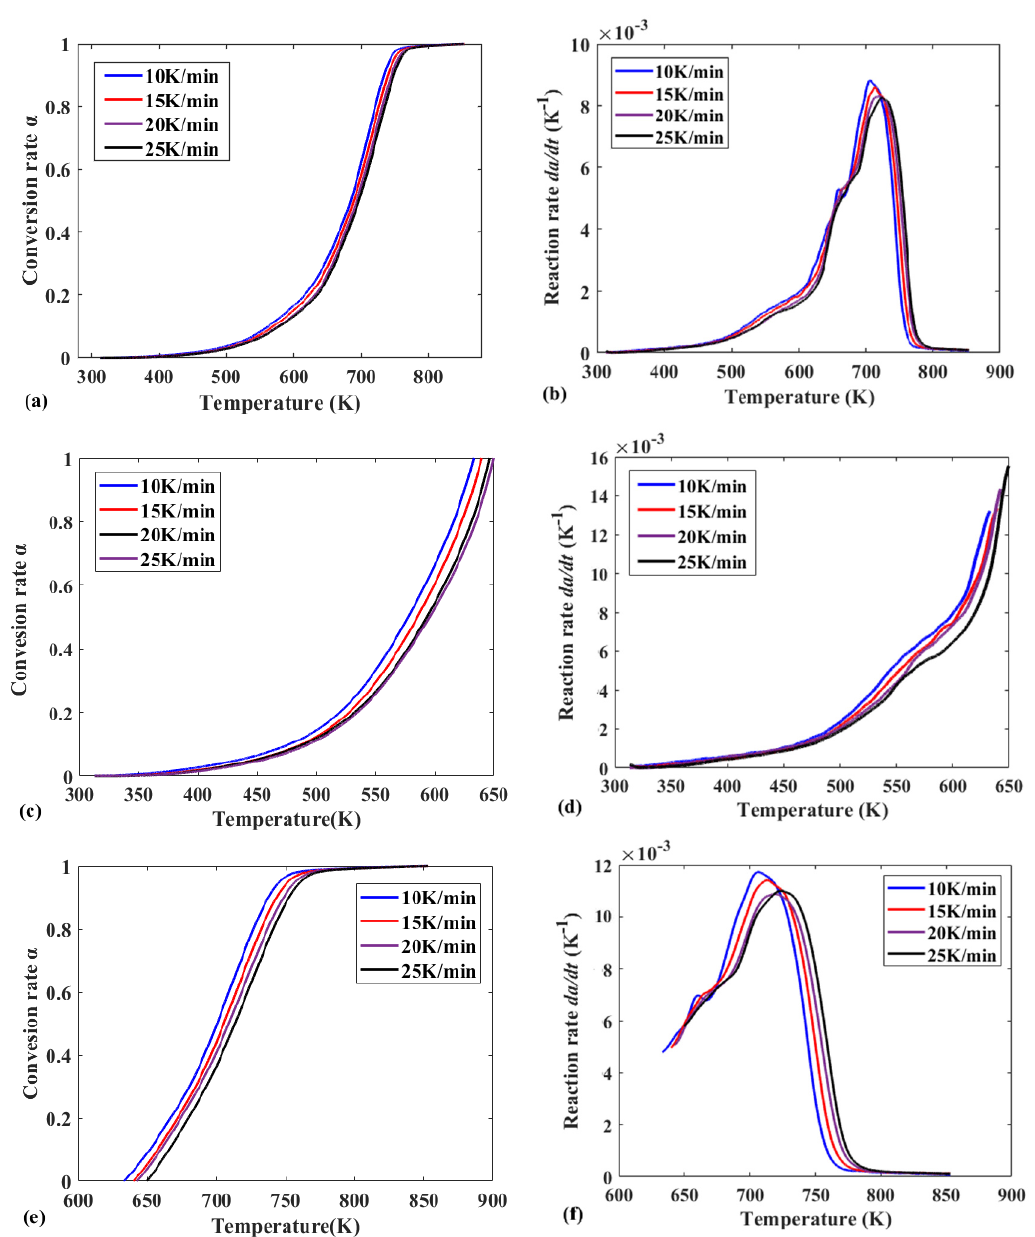
Figure 2. ( a ) Conversion curve of the entire reaction at different heating rates; ( b ) reaction rate curve of the entire reaction at different heating rates; ( c ) conversion curve of Reaction I at different heating rates; ( d ) reaction rate curve of Reaction I at different heating rates; ( e ) conversion curve of Reaction II at different heating rates; ( f ) reaction rate curve of Reaction II at different heating rates.